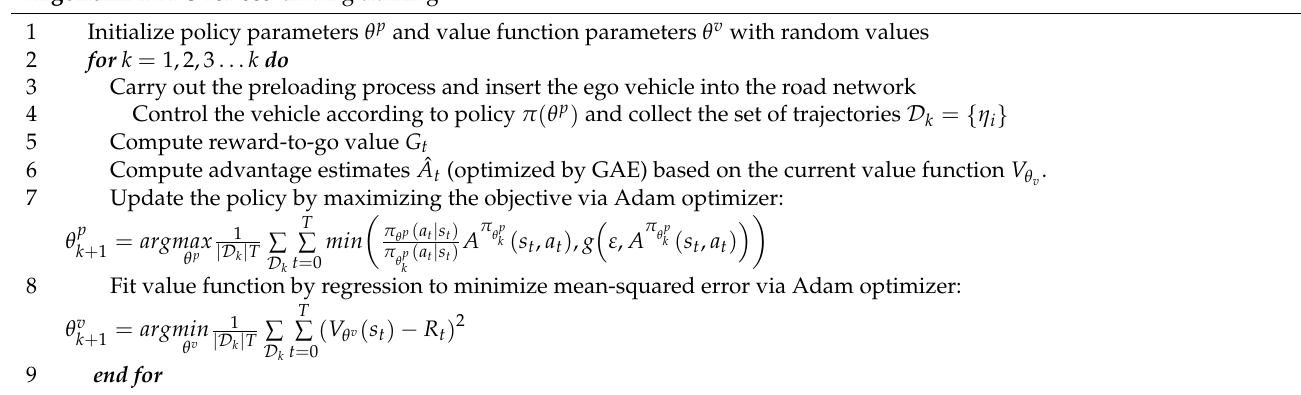
Algorithm 1 PPO for eco-driving